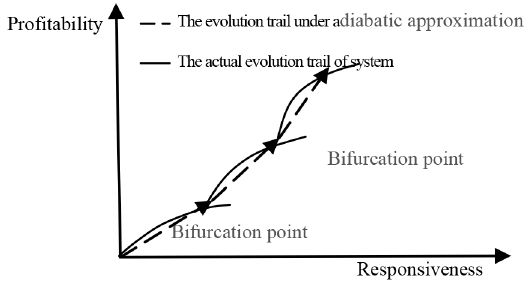
Figure 2. Evolution trail of profitability over responsiveness